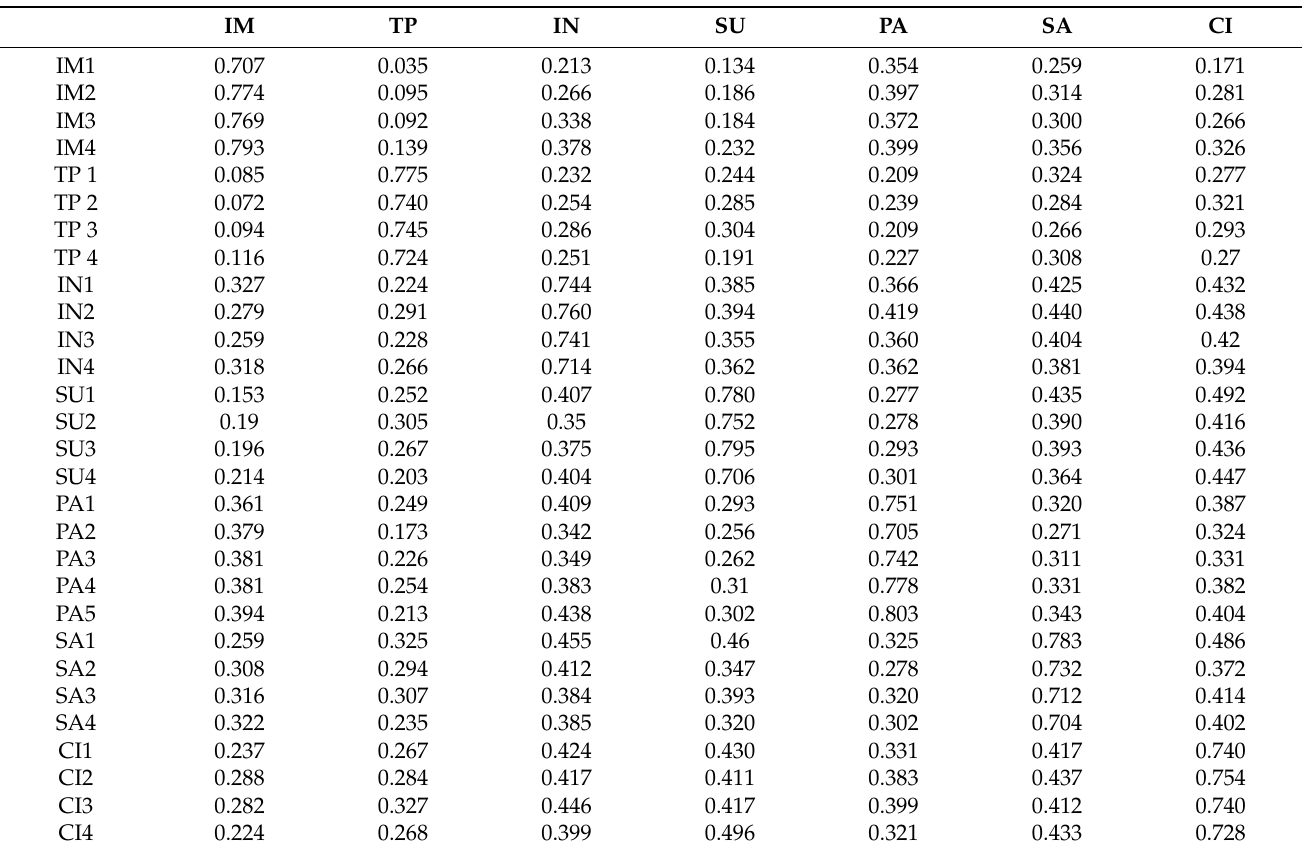
Table 5. Item loadings and